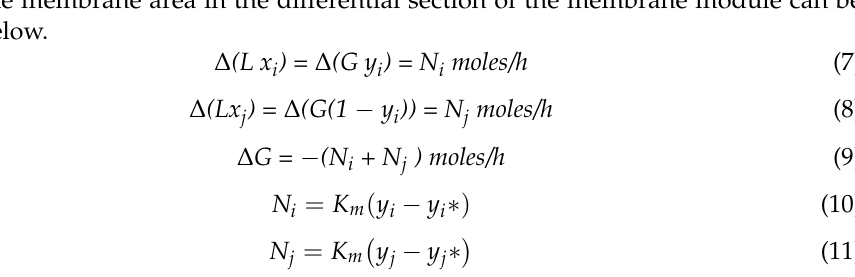
Figure 3. Schematical representation of mass balance across differential section of the hollow fiber membrane module in membrane contactor process: gas flowing in the lumen side of hollow fiber membrane and liquid flowing in the shell side.